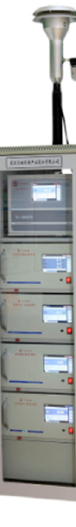
Figure 1. TH-2000. Figure 1. TH-2000.